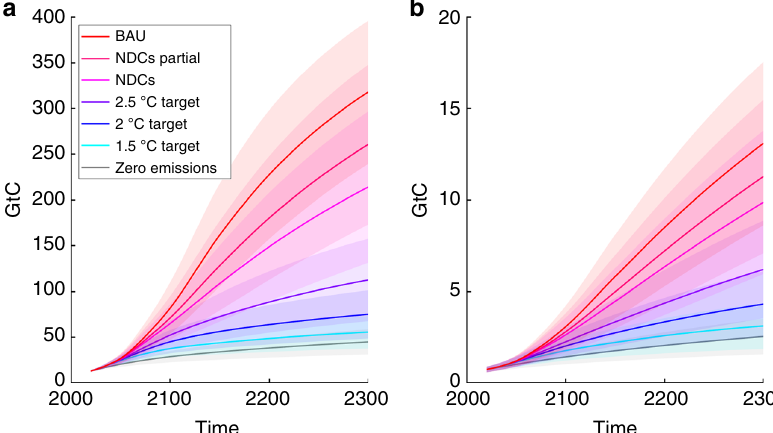
Fig. 7 Cumulative carbon emissions from the permafrost simulated using the dynamic emulator. Cumulative carbon emissions from thawing land permafrost for a CO 2 and b methane components simulated by the new statistical emulator of SiBCASA and JULES (equal weighting) under the chosen range of climate scenarios until the year 2300 (solid lines: mean; shaded areas: ±1SD). 100,000 Monte-Carlo runs of PAGE-ICE. Units: GtC. Note the difference in the Y-axis scale between the plots. Source data are provided as a Source Data fi le